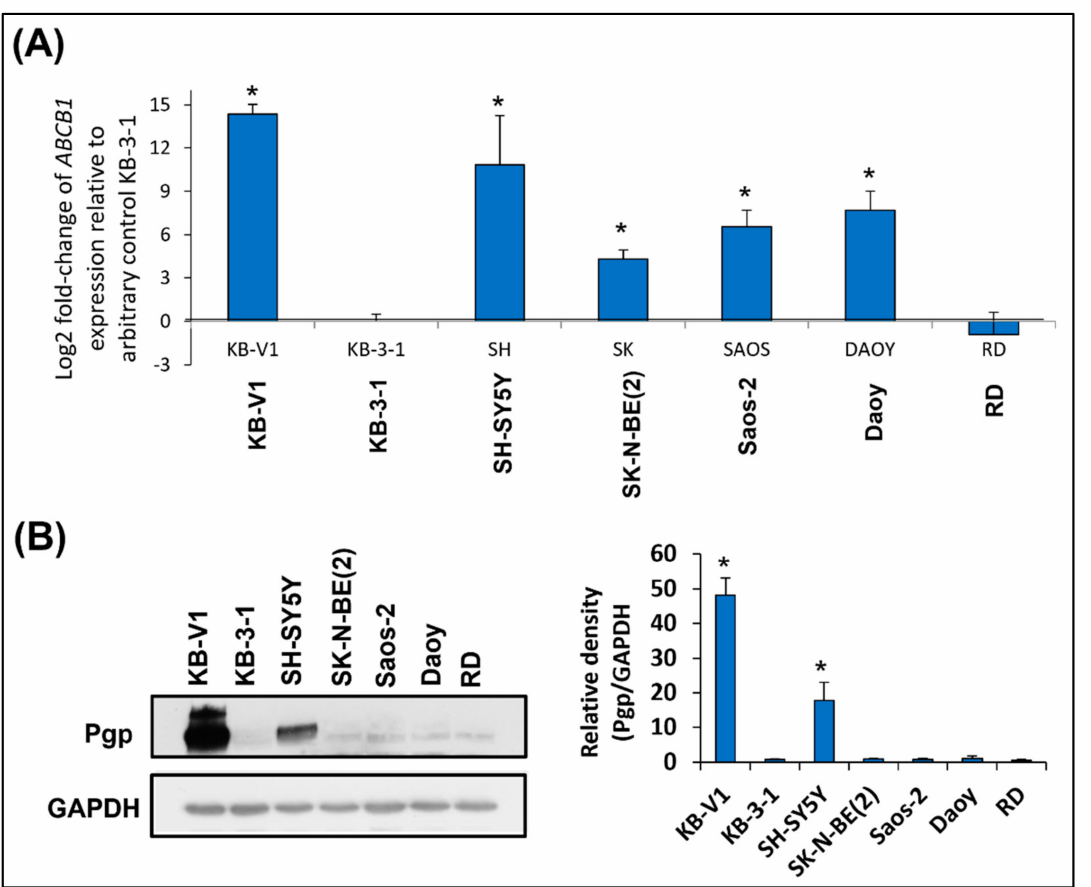
Figure 1. Measuring Pgp in the selected cell lines. KB-V1 cells were used as positive controls for ABCB1 (gene encoding Pgp) expression, whereas KB-3-1 cells were used as negative controls. All experiments were performed in biological triplicates. ( A ) The graph shows the mRNA expression of ABCB1 (the gene encoding Pgp) in untreated cell lines. The data were obtained using RT-qPCR. The levels of ABCB1 expression are presented as a log2-fold change based on mRNA expression relative to that of the negative control (y = 0). GAPDH served as the reference control. The data were analyzed by one sample t -test: * p < 0.05 indicates significant differences compared to the respective control group. ( B ) Immunoblot analysis of the endogenous Pgp level in untreated cell lines. GAPDH served as the loading control. The data are presented as the means ± SD and they were analyzed by unpaired t -test with Welch’s correction: * p < 0.05 indicates significant differences compared to the respective control